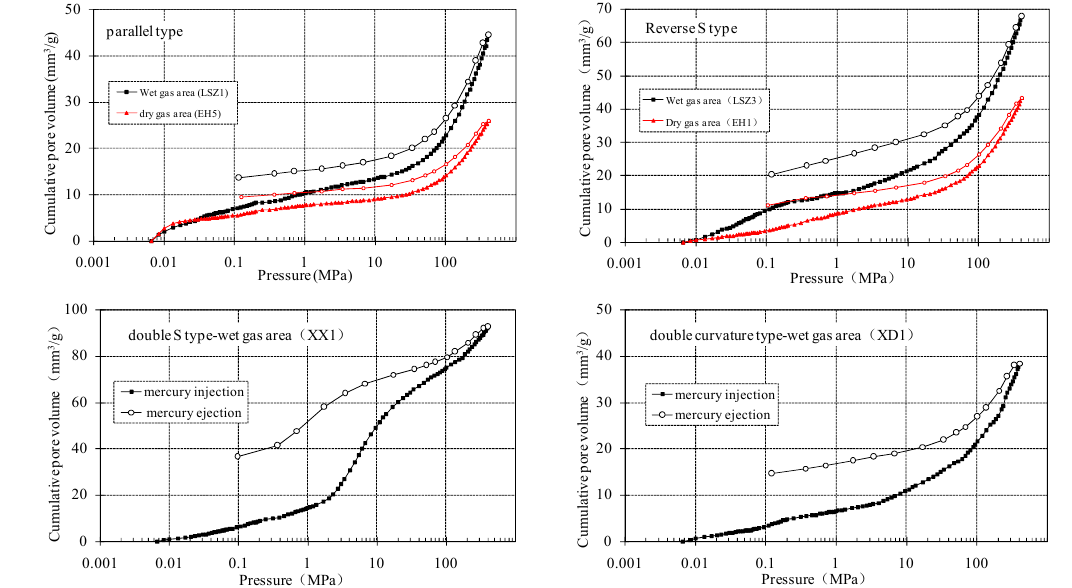
Figure 8. Intrusive mercury curves of four types pore structure.